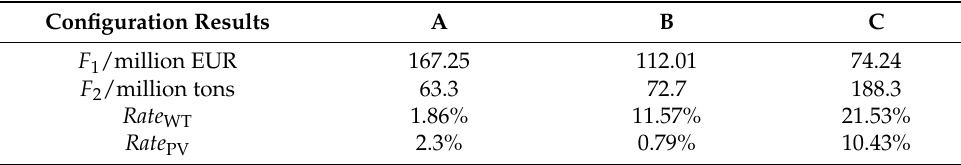
Table 9. Capacity Configuration Results of Microgrid